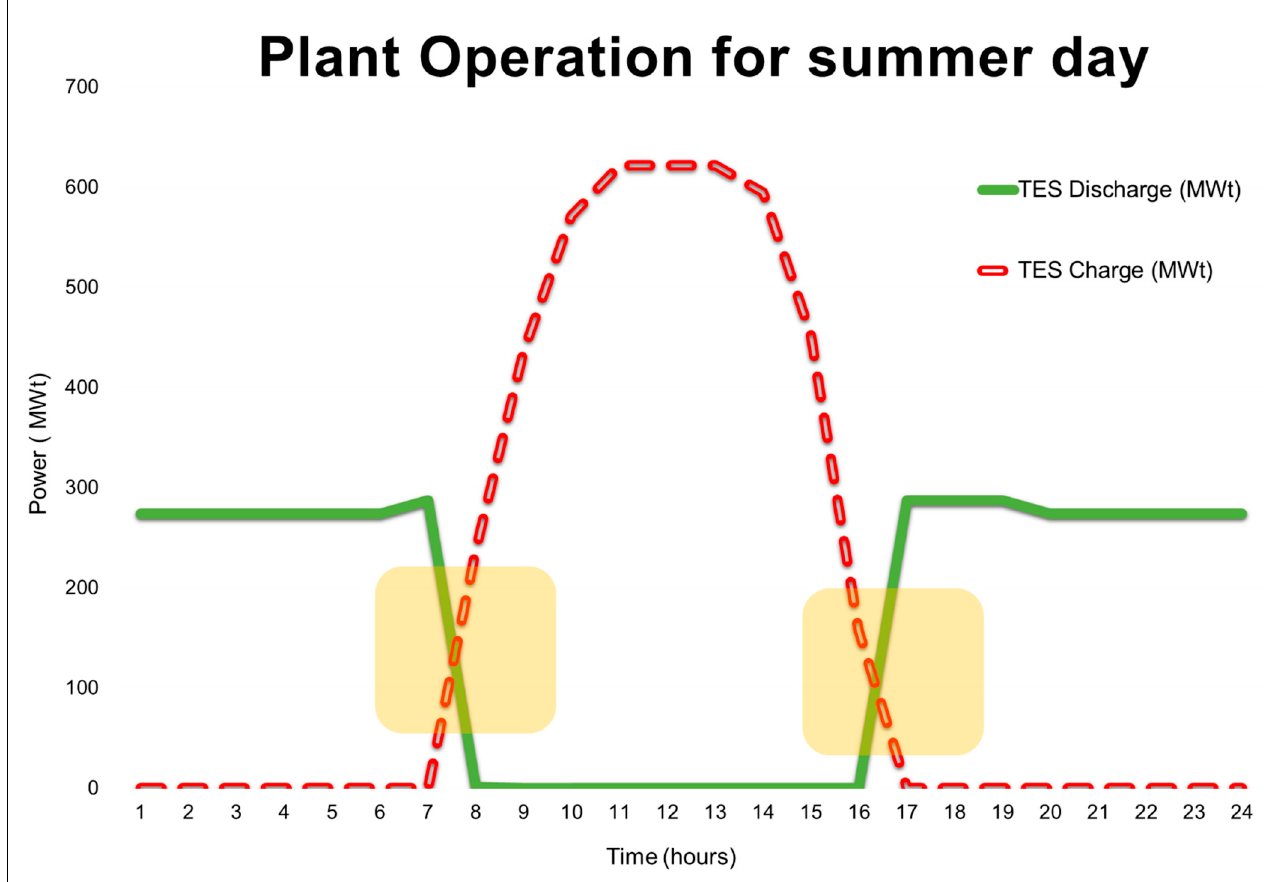
Figure 10. TES load and discharge for a summer day.